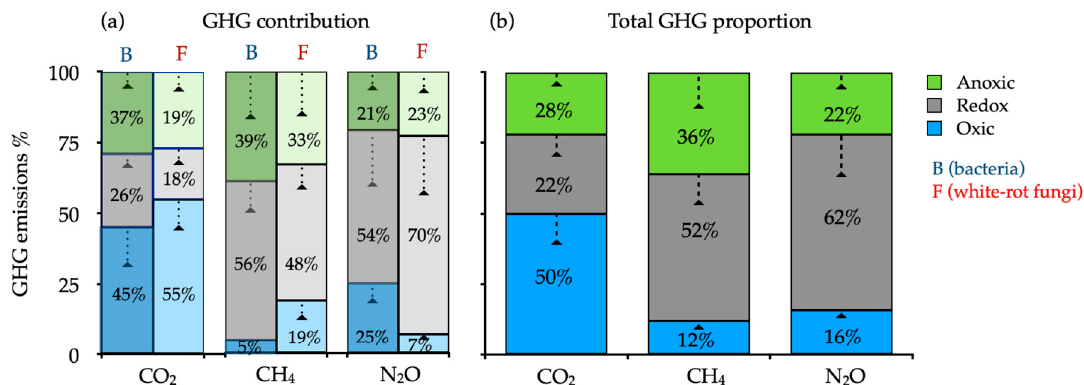
Figure 2. ( a ) Contribution of bacteria and white-rot fungi average to the greenhouse gas emissions (GHG) of sterilized soils and inoculated with white-rot fungi (The letters represent bacteria (B) and white-rot fungi (F) GHG contribution) and ( b ) average of microbial impact (fungi and bacteria) to GHG in temperate rain forests soils incubate for 20 days under oxic, anoxic, and fluctuating redox